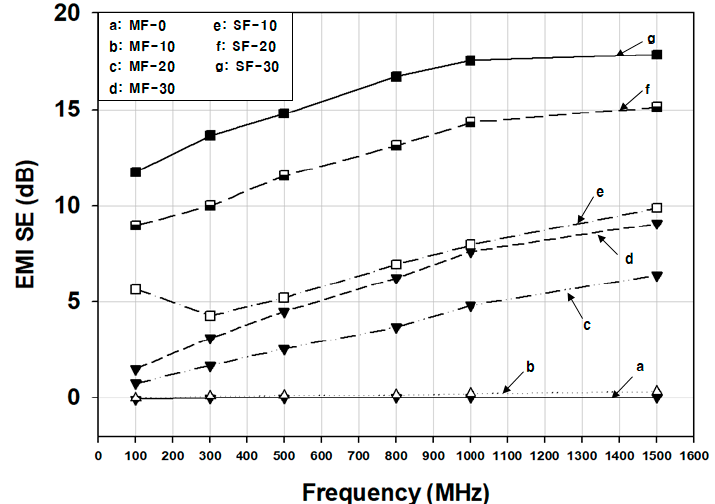
Figure 12. EMI SE variation in the MF-NiCF/PA6 and SF-NiCF/PA6 composites with various NiCF contents as a function of frequency.